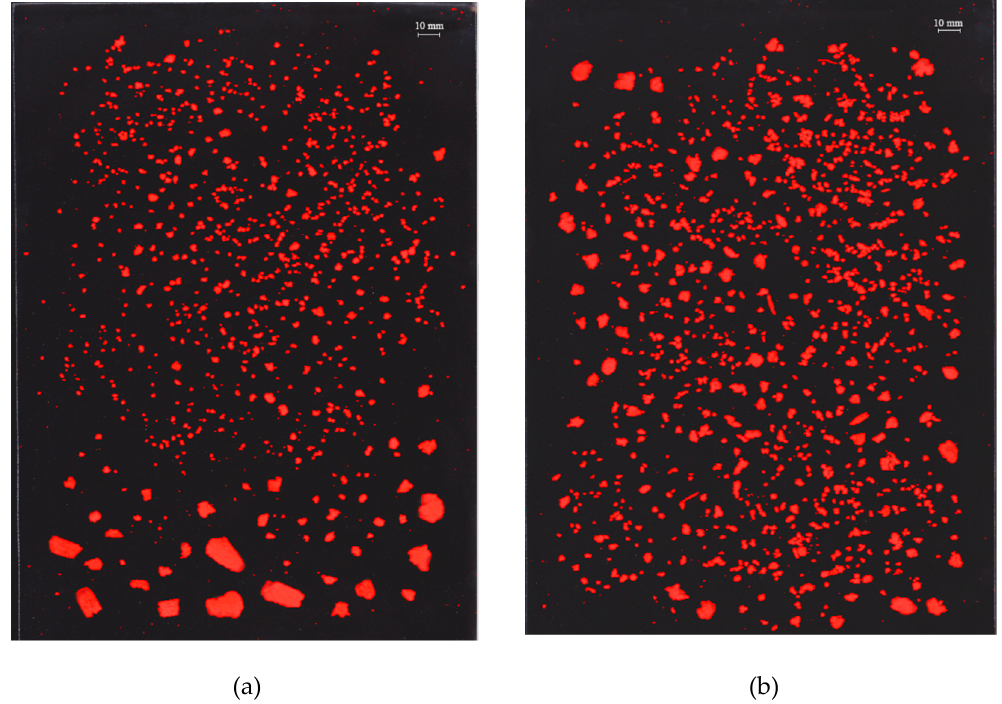
Figure 2. Binarized images showing the particles generated by in vitro fragmentation of samples formulated with ( a ) oat flour with baking powder and ( b ) big oat flakes with baking powder.